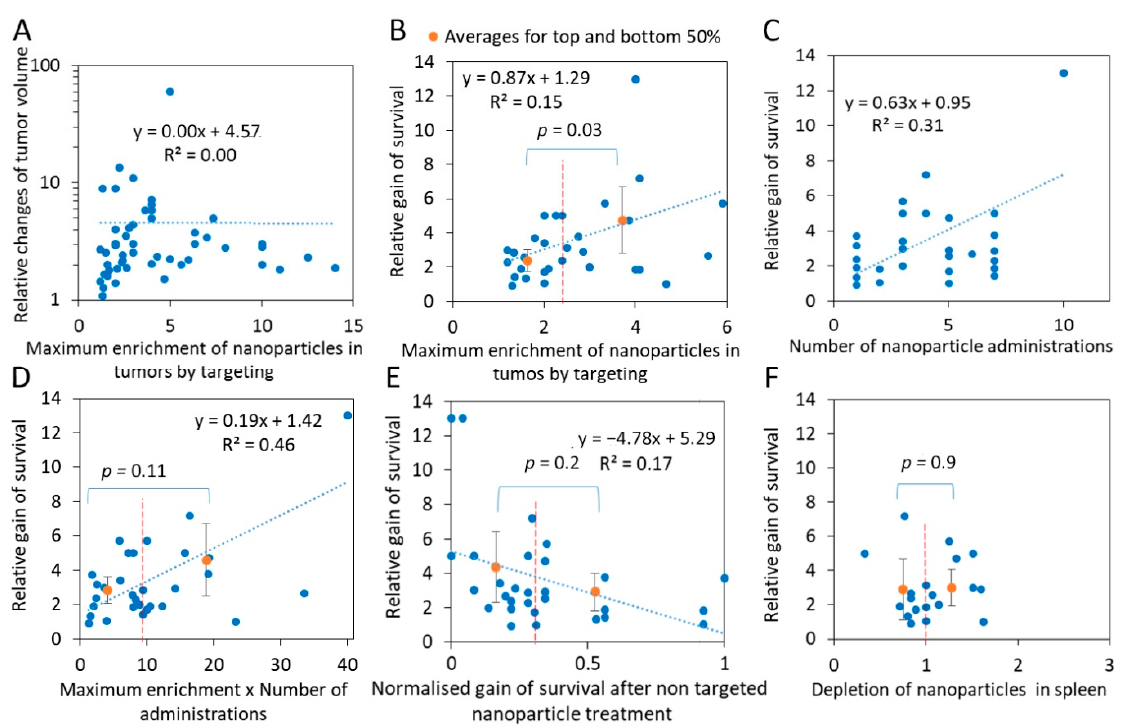
Figure 3. Nanoparticle targeting enhances cancer survival. Here, blue dots are raw data and orange dots are averages for top and bottom 50% of the abscissa values. ( A ) The relative gain of tumor volume ( vNT-vInitial )/( vT-vInitial ) does not correlate with the maximum enrichment of nanoparticle concentration in tumors by targeting. ( B ) The relative gain of survival ( sT-sContr )/( sNT-sContr ) correlates with the maximum ENT . ( C ) The gain of survival as a function of the number of drug administrations. ( D ) The gain of survival as a function of the maximum ENT multiplied by the number of drug administrations. ( E ) The relative gain of survival does not correlate with the normalized gain of survival for mice treated with non-targeted nanoparticles. ( F ) The relative gain of survival does not correlate with depletion of the nanoparticles in spleen.